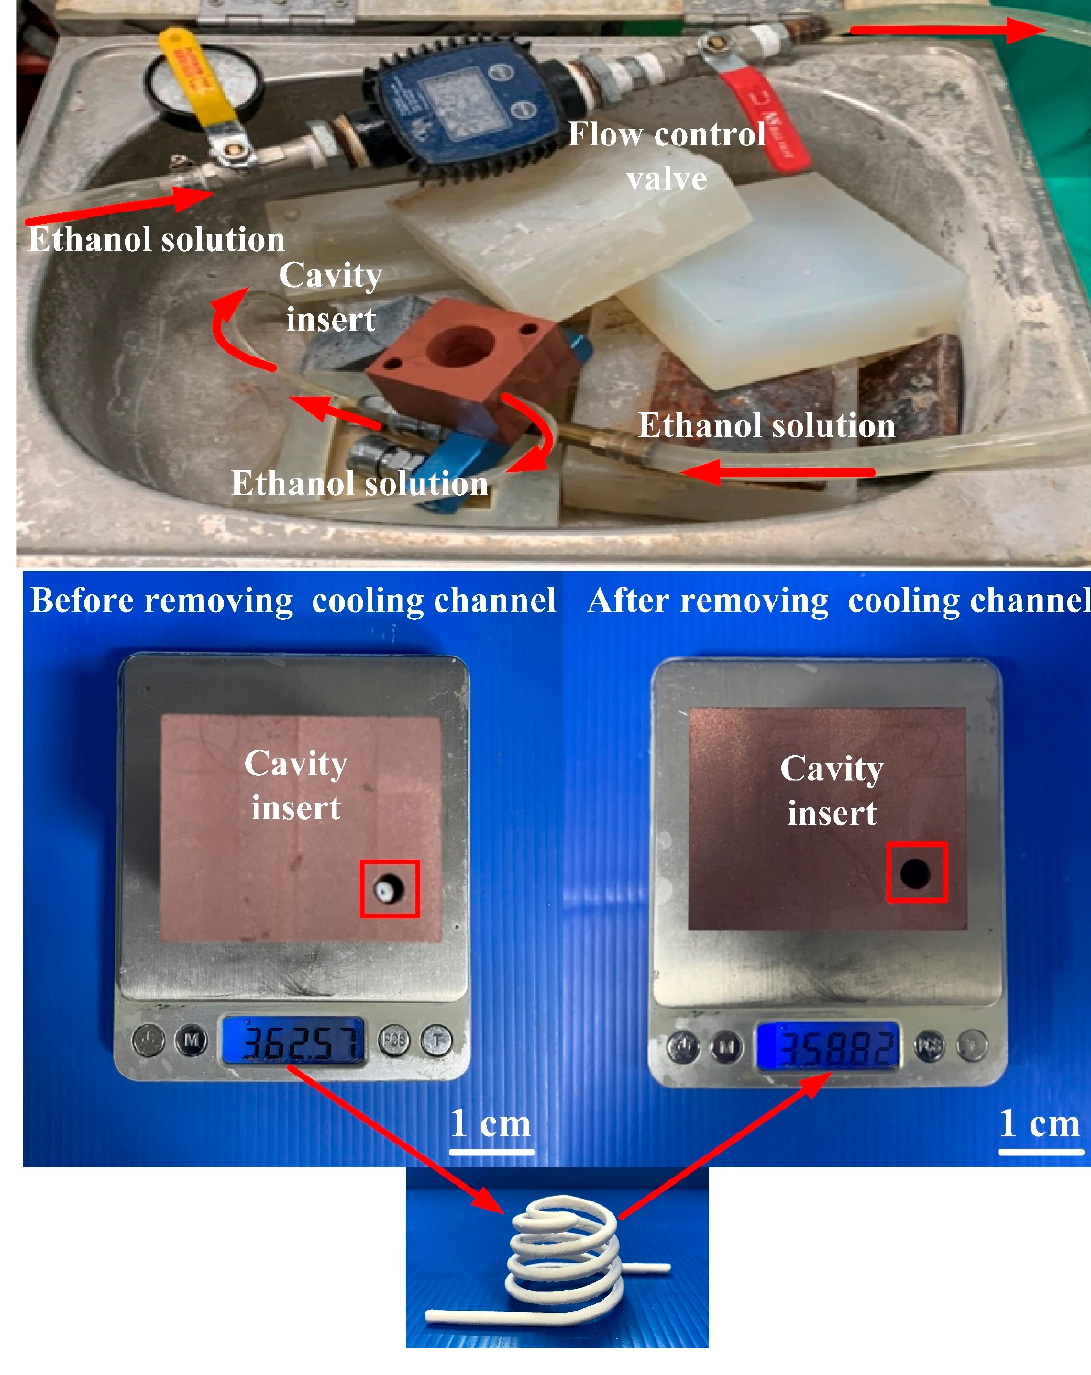
Figure 18. Wax injection mold before and after removing PCCC. To investigate the precipitation of the fillers in the rapid mold, the EDS analysis was carried out in this study. Figure 21 shows the precipitation analysis of the injection mold fabricated by epoxy resin added with Cu powder. As can be seen, the Cu element content at the top, middle, and bottom of the core inserts were approximately 43%, 42%, and 43%, respectively. The percentages of Cu at the top, middle, and bottom of the ERM were similar, showing that the added Cu powder could be distributed uniformly in the injection